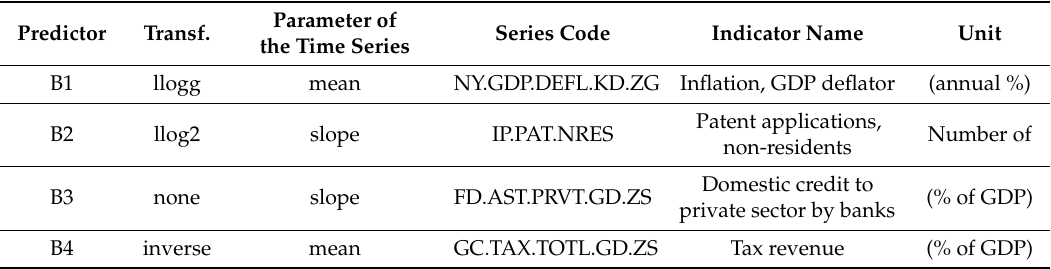
Table 5. Description of the regressors incorporated into the models of Table